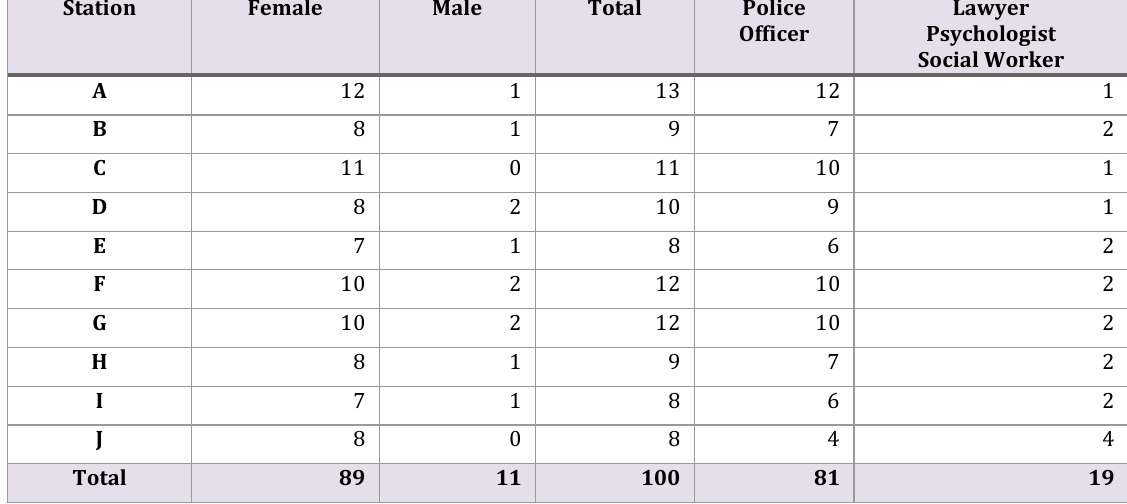
Table 1: Interviews by Sex and Profession, Women ’s Police Stations Buenos Aries Province Station